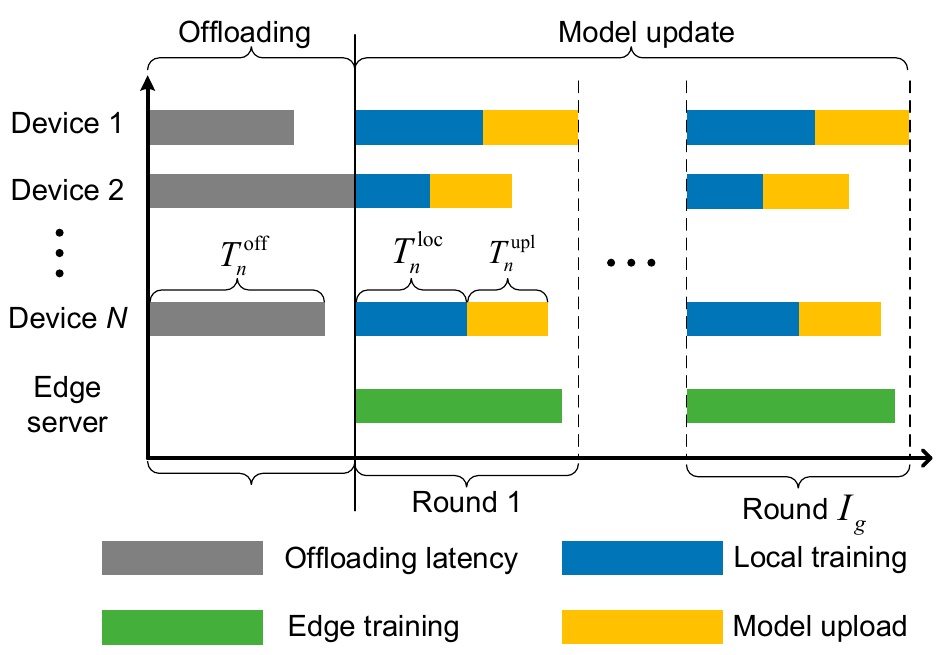
Figure 2. The illusion of system latency in the proposed edge-assisted FL framework.